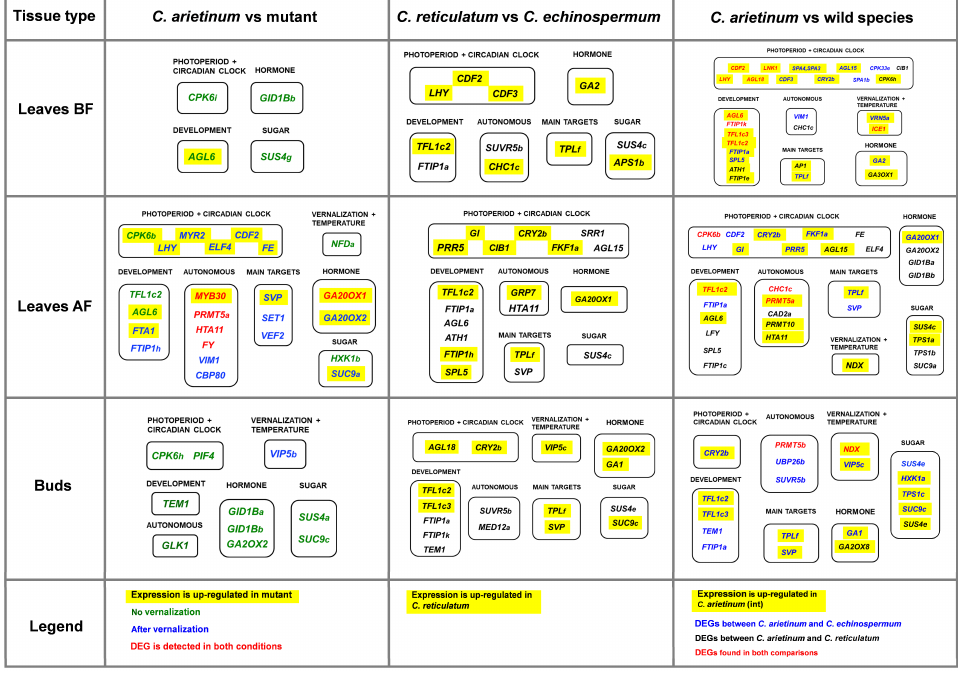
Figure 5. Flowering time genes differentially expressed in three comparisons between species/accessions: (1) C. arietinum vs. ICCV 96029 mutant; (2) C. reticulatum vs. C. echinosper- mum ; (3) C. arietinum vs. two wild species ( C. reticulatum and C. echinospermum ). Each box represents the developmental pathway (see Figure 1). Gene upregulation in the particular species/accessions is shown by yellow shading of the gene‘s name. Different comparisons are indicated by the text color (see legend at the bottom of the